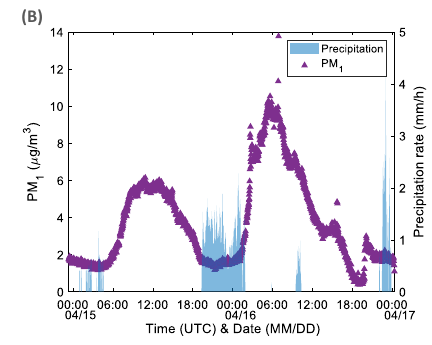
focus of this study. B Particulate matter with diameter smaller than 1 µ m (PM 1 , left axis,purpletriangles)andprecipitationrate(rightaxis,shadedarea),thetwopeaks of the warm intrusion event are separated by